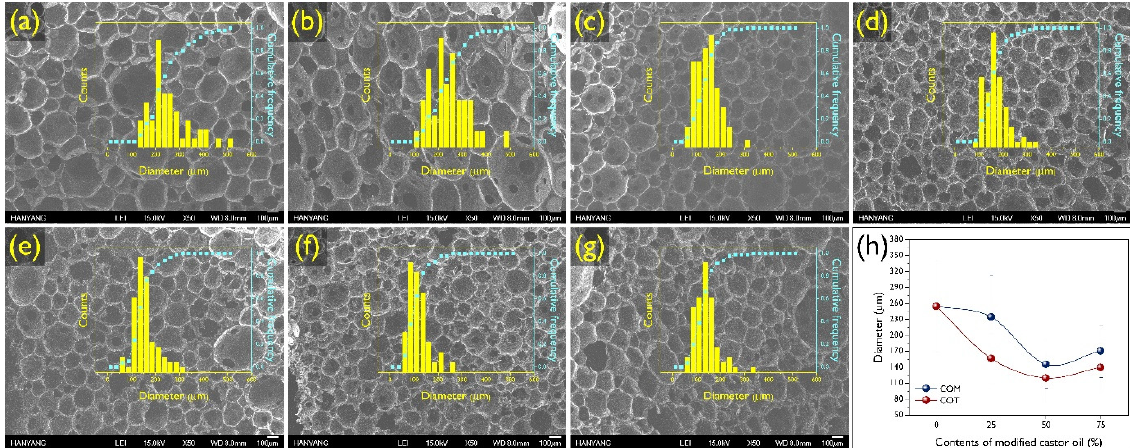
Figure 4. SEM micrographs and cell diameter distribution of PU foams prepared with various polyols: ( a ) CO, ( b ) COM25, ( c ) COM50, ( d ) COM75, ( e ) COT25, ( f ) COT50, and ( g ) COT75. ( h ) Changes in the average cell diameter of the PU foams.